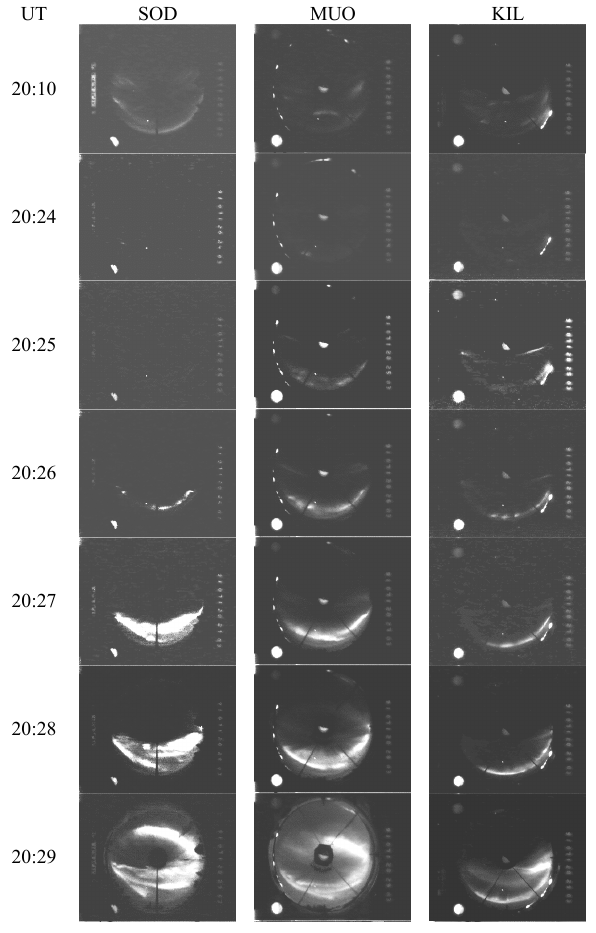
Fig. 2. All-sky camera images taken at SOD, MUO and KIL during the substorm on 12 March 1991. The north (and east) is/are at the top (and right) side of the images.